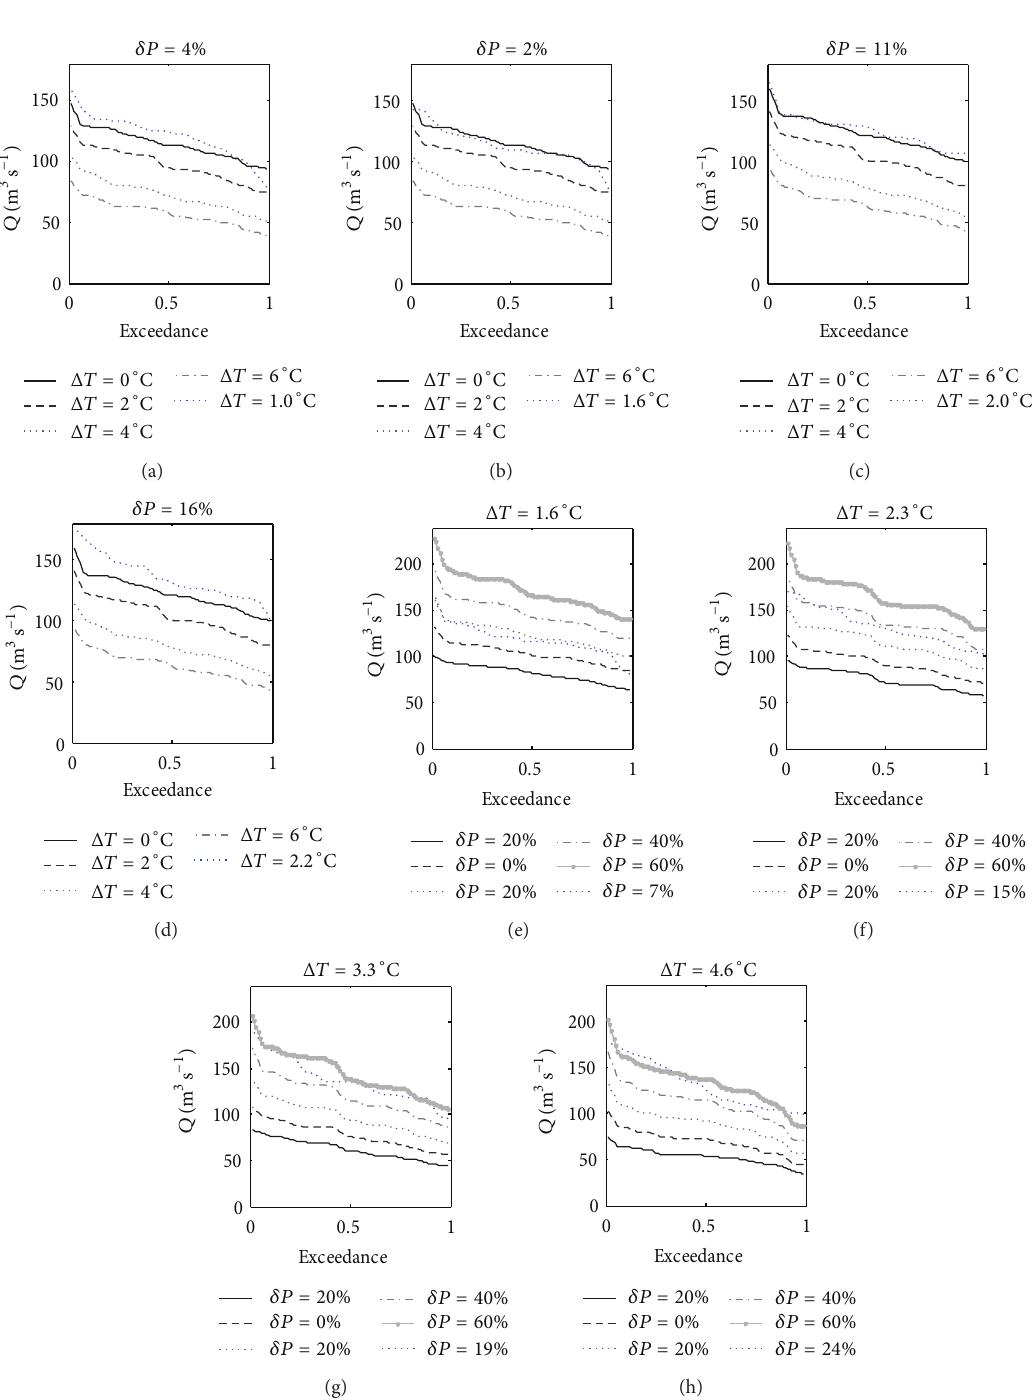
Figure 5: Exceedance probability curves of average annual streamflow ( 𝑄 ) in response to temperature change and precipitation change based on SCC with each plot either with fixed precipitation change (a ∼ d) or with fixed temperature change (e ∼ h). Dotted blue line in each plot denotes exceedance probability curves of average annual streamflow for the simulation with RCM outputs given fixed 𝛿𝑃 and Δ𝑇 as summarized in Table